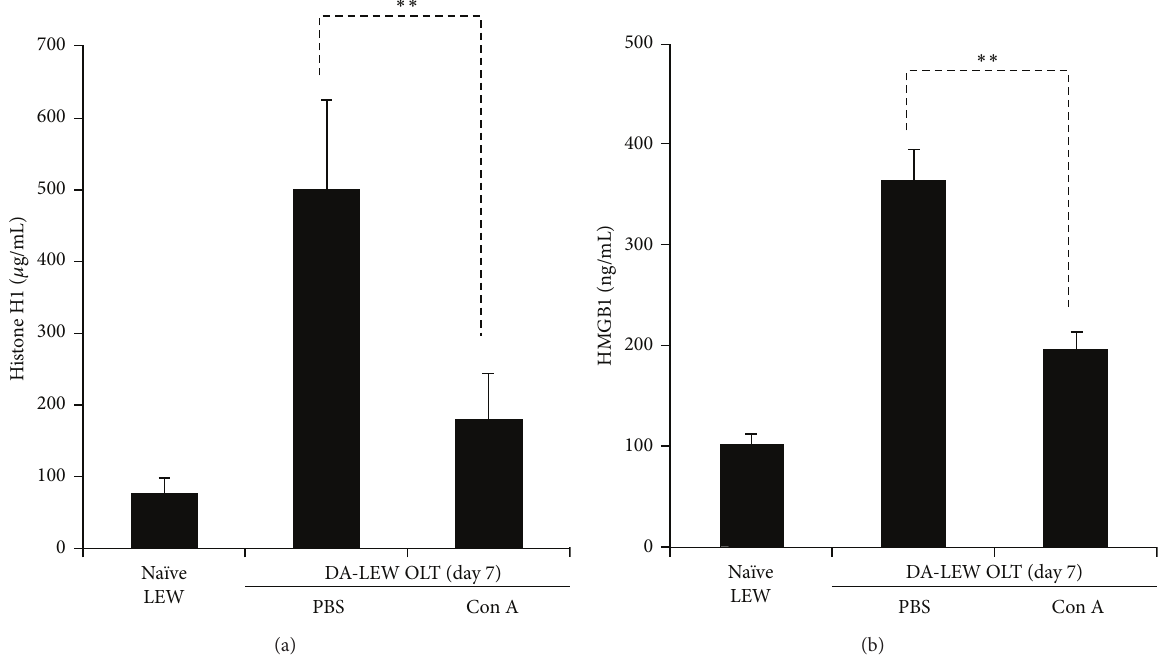
Figure 2: The circulating levels of nuclear histone H1 (a) and HMGB1 (b) during the rejection phase after OLT. For the quantitative determination of histone H1 and HMGB1, sandwich ELISA was performed as described in the Materials and Methods section. The results are expressed as the mean of three independent experiments ± SD. ∗∗ Significantly different compared with the control PBS group ( 𝑛 = 5 ) ( 𝑃 < 0.01 , Student’s t